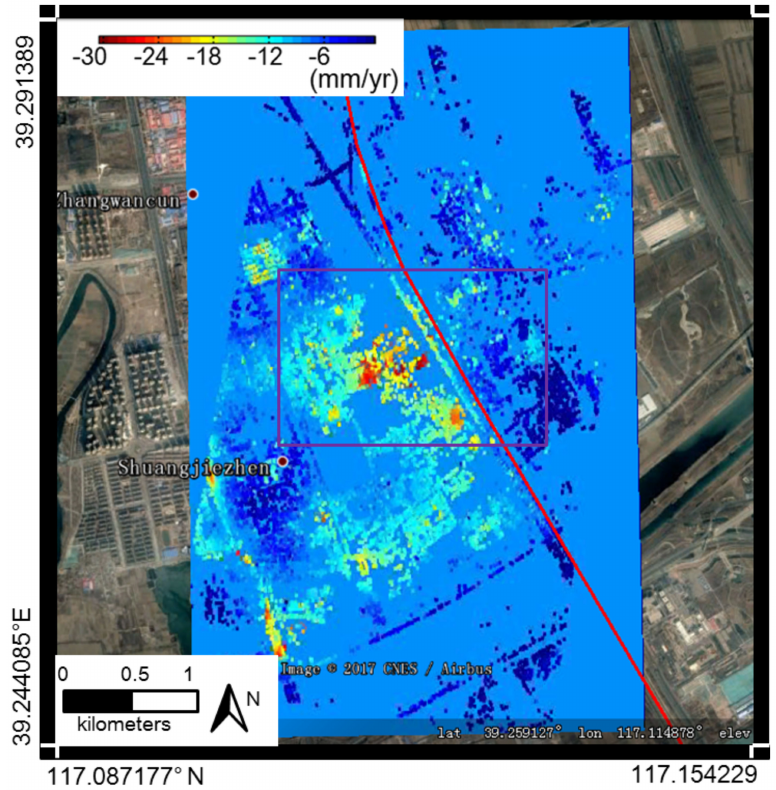
Figure 3. Linear deformation trend in the selected area, resampled on a regular grid in geographical coordinates. The red line crossing the image represents the path of the Jingjin Highspeed Railway. The purple rectangle marked the sub area as illustrated in Figure